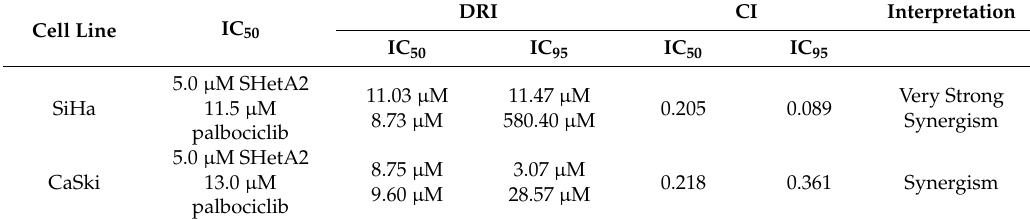
Table 1. Chou-Talalay method results of SHetA2 and palbociclib combination.